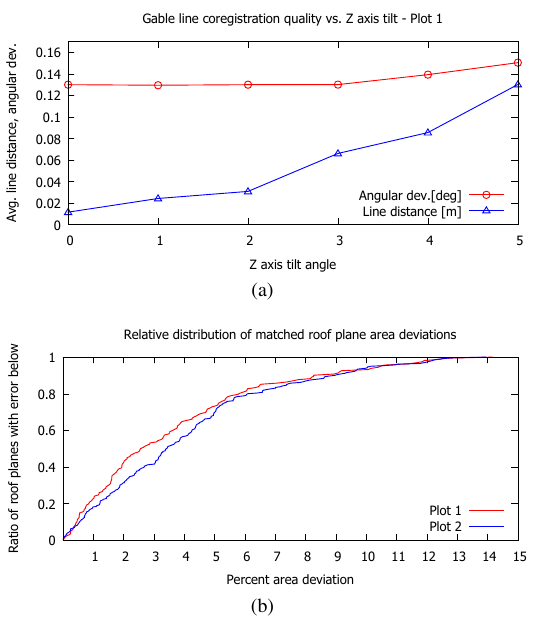
line coregistration quality vs. Z axis tilt - Plot 1